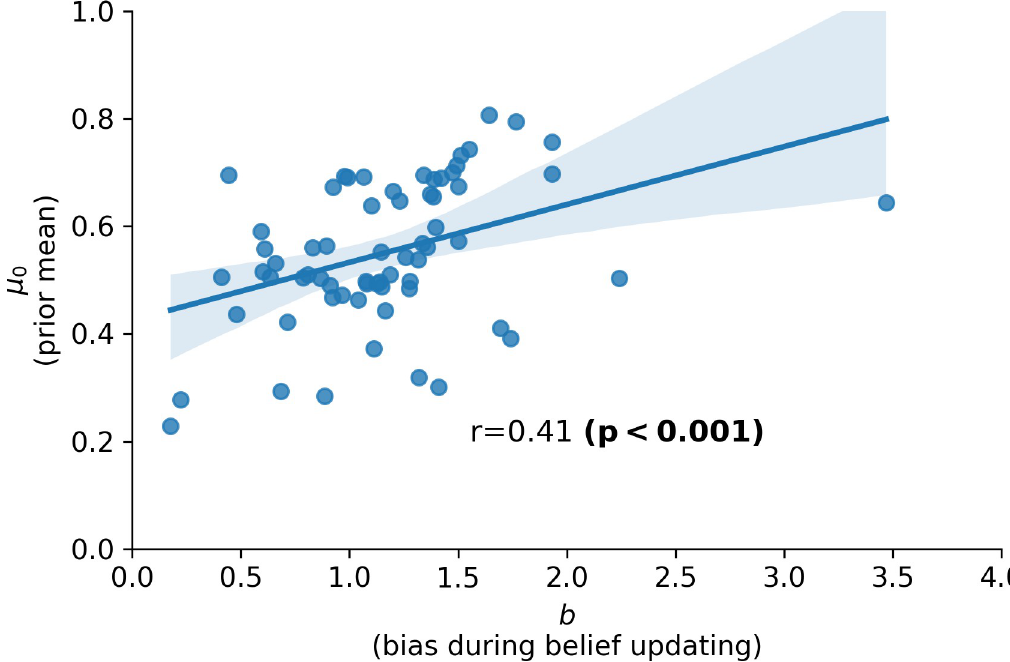
Fig 5. Evidence for a confirmation bias for other-referent beliefs. Parameter estimates for the prior mean ( μ 0 ; y-axis) and bias in belief updating ( b ; x-axis), obtained using the winning model (Model 3: the “biased RW” model), are significantly correlated across participants (r = 0.41, p < 0.001); this relationship also holds without the outlier, r = 0.44, p < 0.001). Thus, participants, as a group, tend not only to show a confirmation bias when updating beliefs related to themselves (as shown in Fig 4) but also when updating their beliefs about other participants. Here, a confirmation bias means that positive/negative feedback is incorporated more strongly into beliefs when it aligns with prior beliefs.